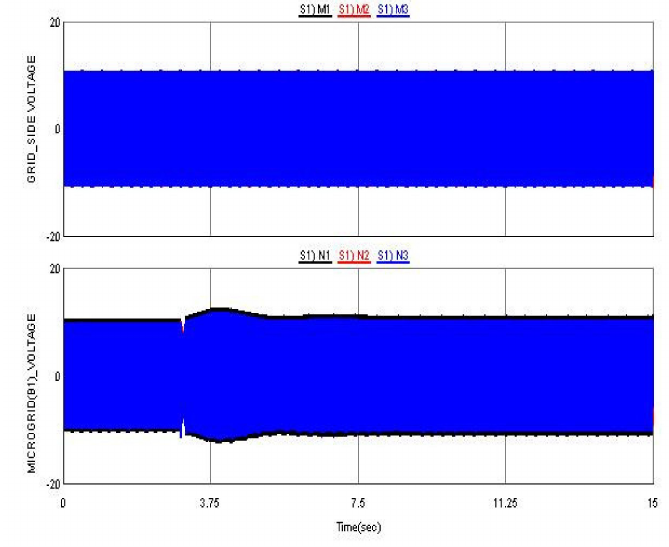
Figure 21. Non-shed able Critical load active powers (Loads at Buses 5–7).